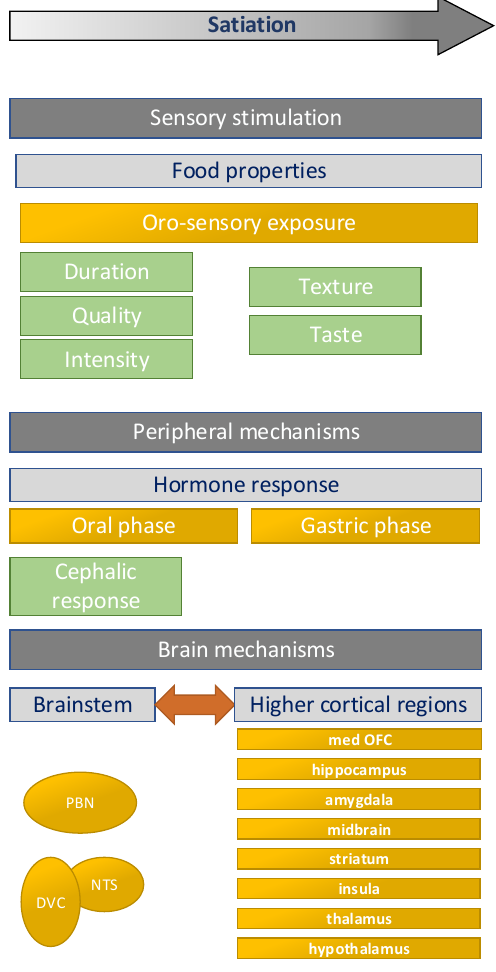
Figure 1. Overview of the factors involved in the relation between oro-sensory exposure and food intake. This figure is based partly on Hopkins and Blundell et al. [1,9]. PBN = parabrachial nuclei, NTS = nuclei of the solitary tract, DVC = dorsal vagal complex, med OFC = medial orbifrontal cortex.